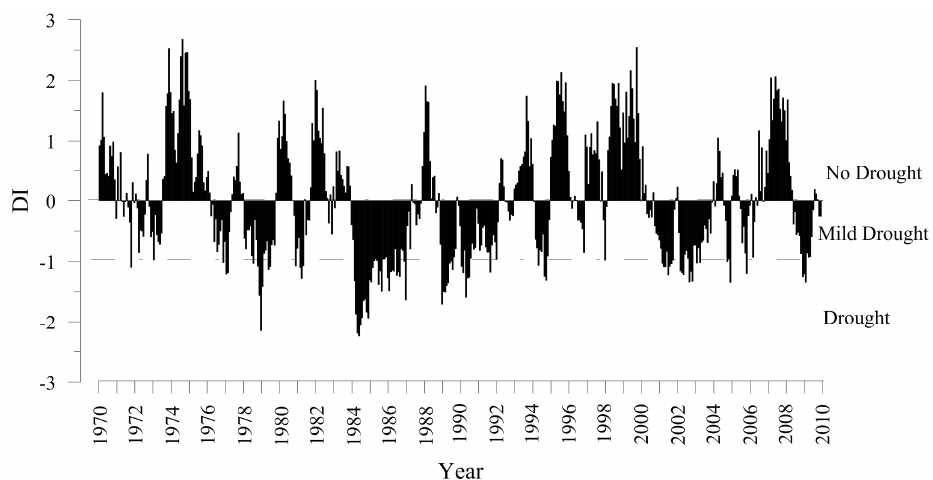
Figure 3. Time series of the DI (1971–2010).